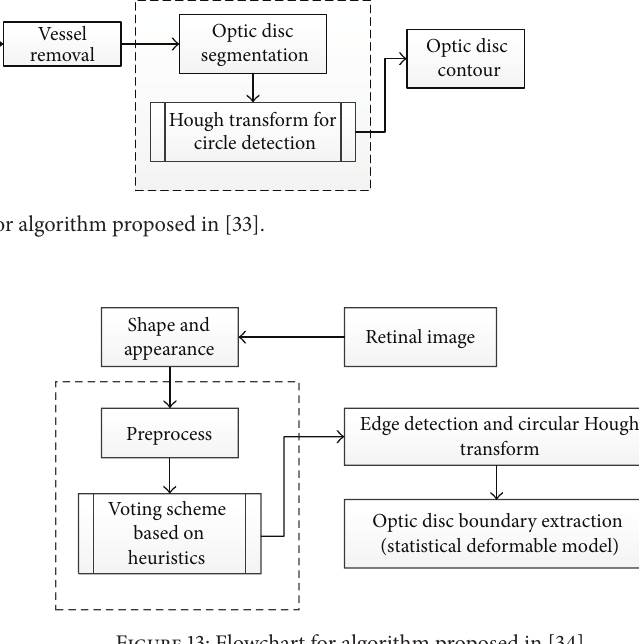
Figure 13: Flowchart for algorithm proposed in